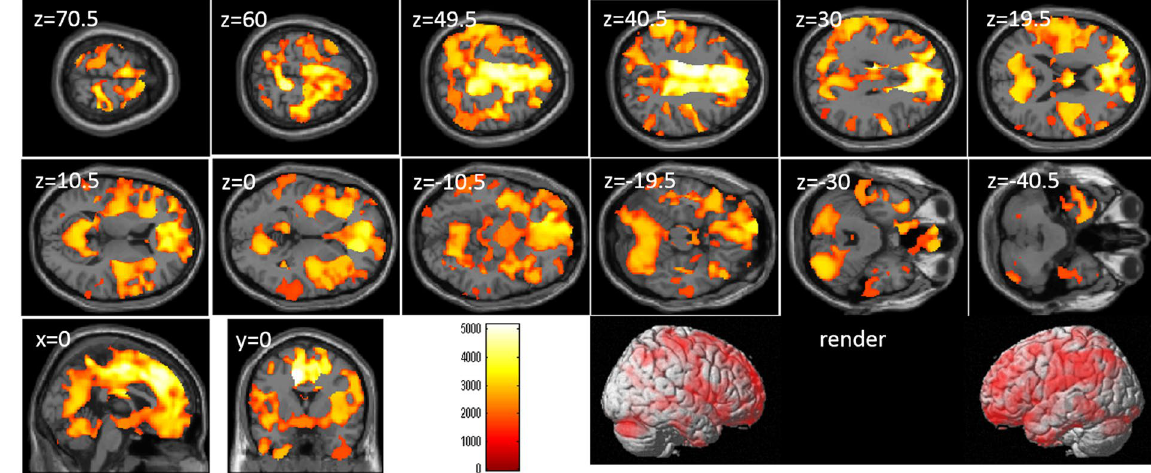
Figure 3. Relationships between rGMV and performance on tasks of the attention/inhibition component of executive function. Panels show areas of significant negative correlation between Stroop interference and rGMV by multiple regression analysis corrected for effects of age, sex, and control task performance (Color-Word task). The results shown were obtained using a threshold of TFCE, P < 0.05 corrected (FWE) based on 5000 permutations. In section images, the color bar represents the TFCE value. Significant positive correlations were found across the whole brain.